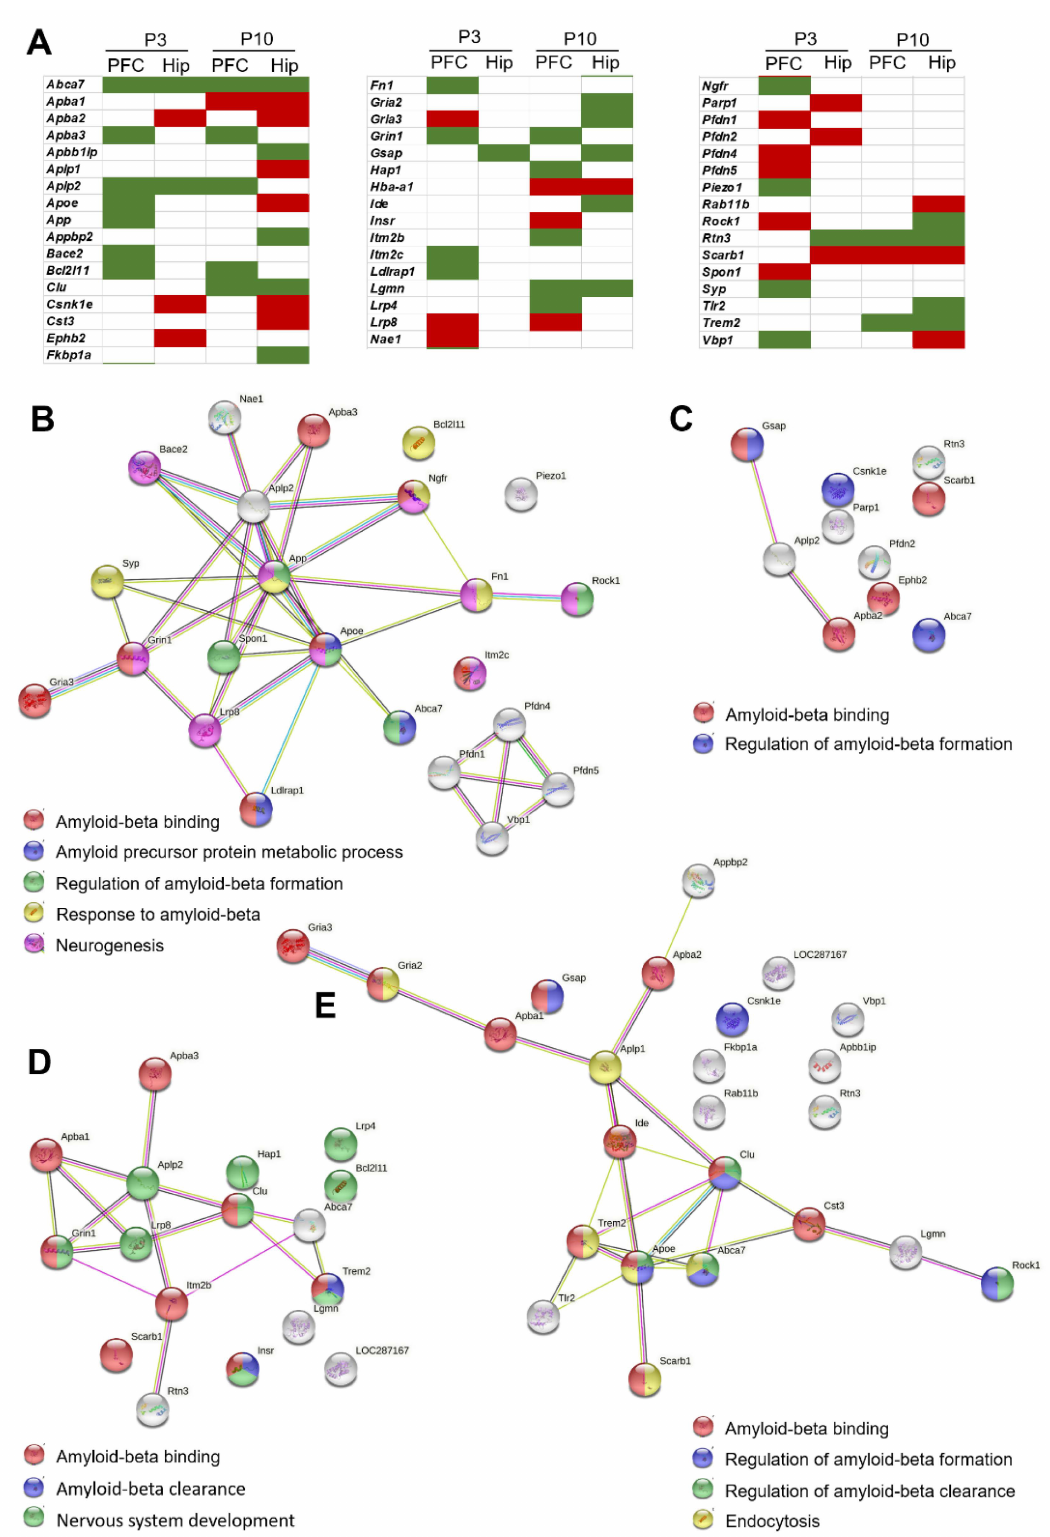
Figure 3. Changes in gene expression related to the function of A β in OXYS rats. ( A ) Up- and downregulated DEGs in the PFC and hippocampus of 3- and 10-day-old OXYS rats compared to age-matched Wistar rats. GO terms according to STRING for sets of DEGs ( B ) in the PFC at P3, ( C ) in the hippocampus at P3, ( D ) in the PFC at P10, and ( E ) in the hippocampus at